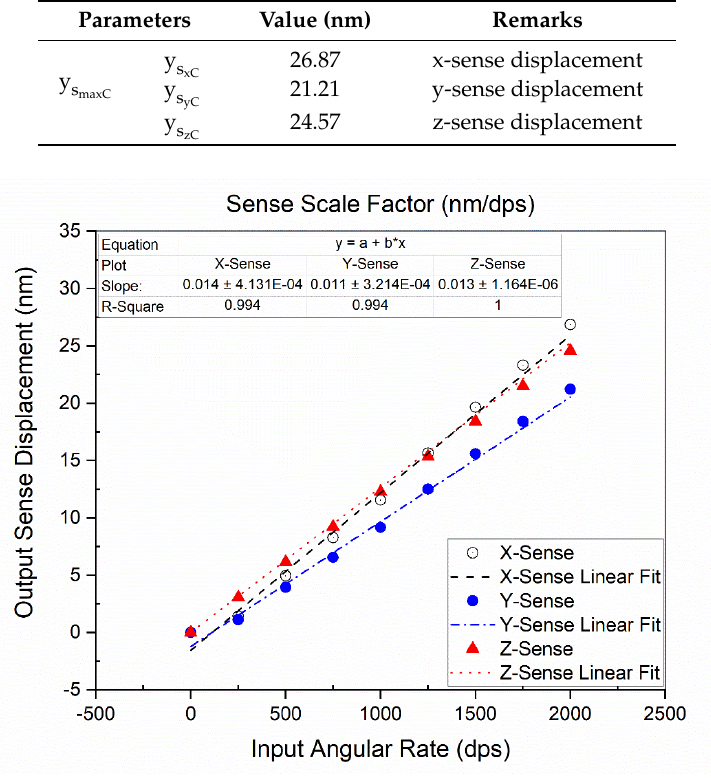
Figure 8. Scale factor plot of the proposed single-drive, 3-axis MEMS gyroscope.